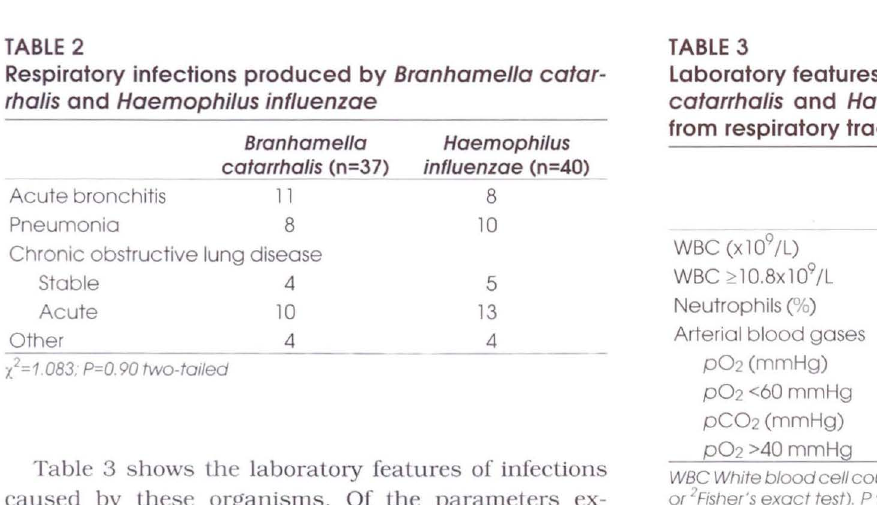
laboratory features of patients from whom